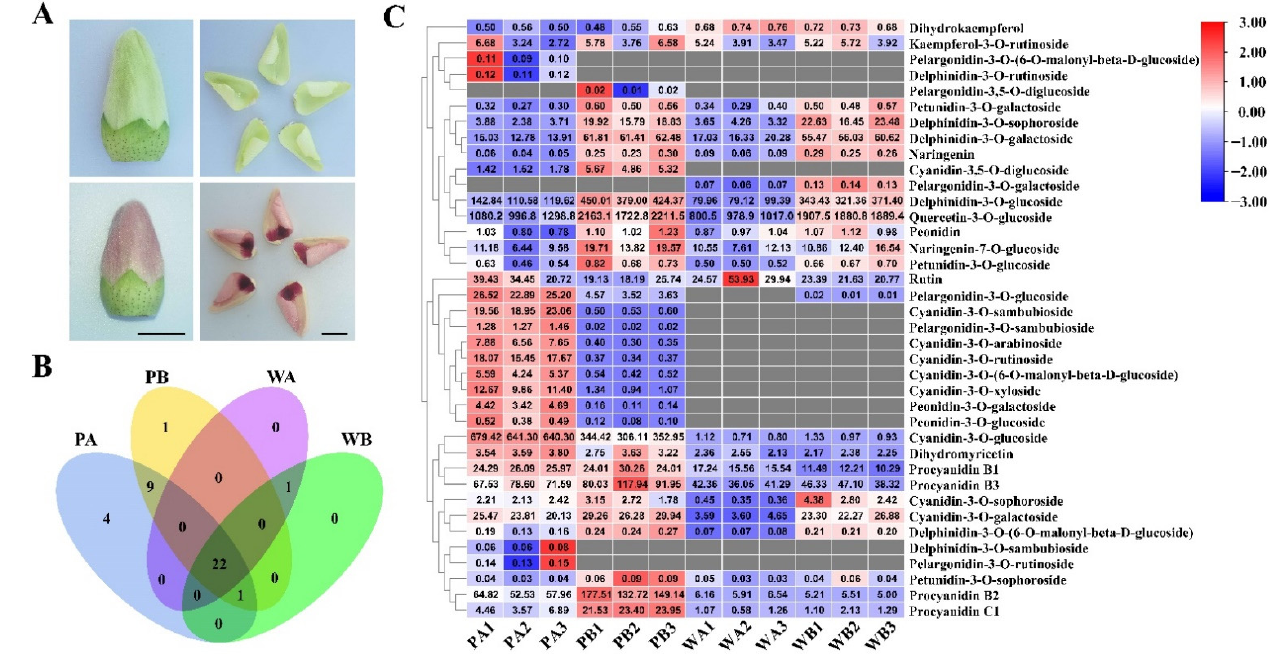
Figure 2. Phenotypes of XinLuZao 74 (X74) and Pink Flower ( PF ), and preliminary analysis of metabolomics data. ( A ) Sampling period for metabolite analysis and RNA-sequencing (RNA-Seq) analysis. Scale bar: 1 cm. ( B ) Venn diagram of metabolites accumulated in different regions of petals of X74 and PF . ( C ) Cluster heat map of the 38 anthocyanin metabolites in the X74 and PF cultivars. Intensity values were adjusted by log transformation and then normalized. PA, PB, WA, and WB represent the spot region and non-spot region of PF and X74 petals, respectively. PA1/PA2/PA3, PB1/PB2/PB3, WA1/WA2/WA3, and WB1/WB2/WB3 represents three biological replicates for each sample, respectively.